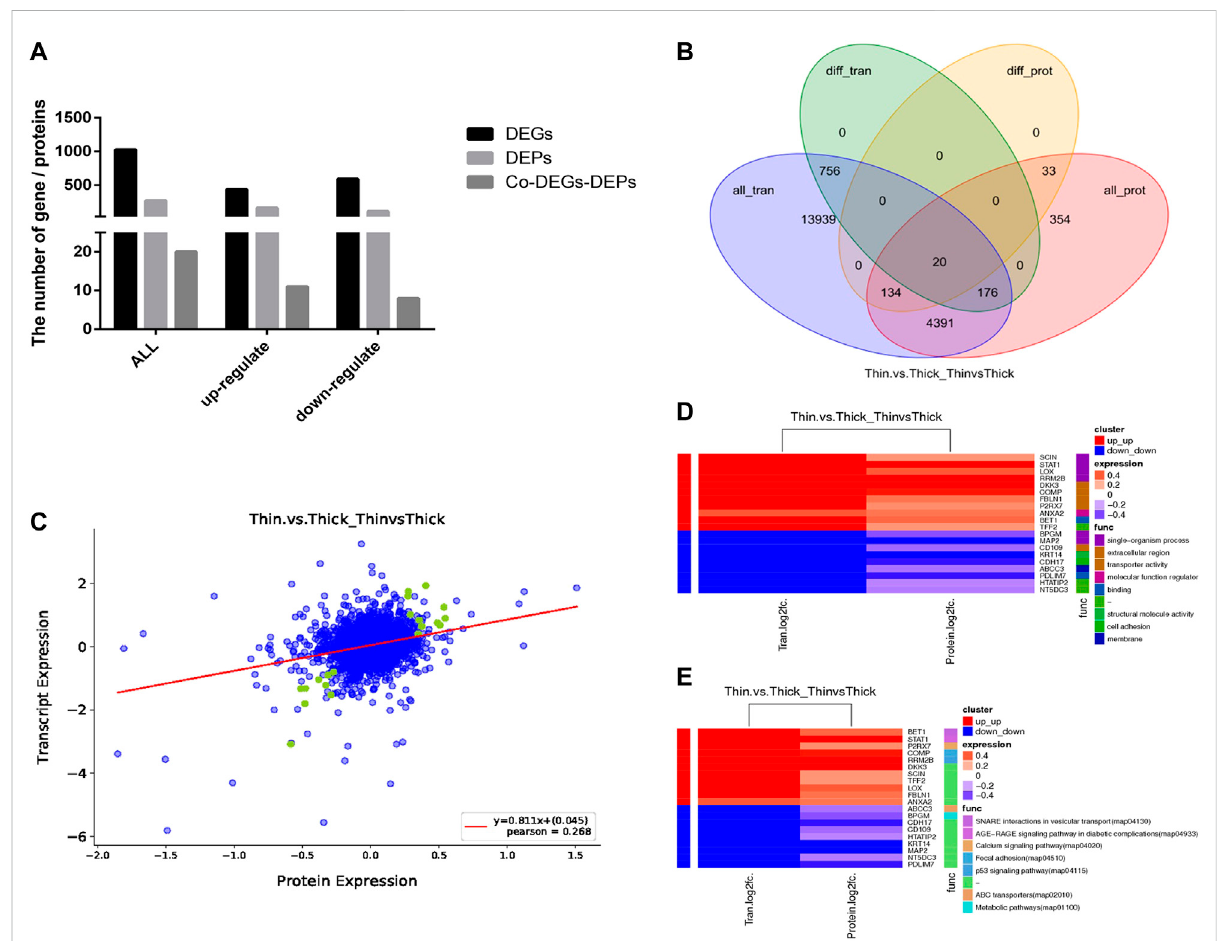
FIGURE 3 Integration and analysis of transcriptome and proteome between HE and LE groups. (A) . DEGs, DEPs, and Co-DEGs-DEPs between HE and LE groups; (B) .Venn diagramfor DEGs andDEPsbetween HE andLEgroups; (C) . Corr_plot ofRNA-seq andTMT between HE andLEgroups; (D) .Share GO analysis of RNA-seq and TMT between HE and LE groups; (E) . Share KEGG analysis of RNA-seq and TMT between HE and LE